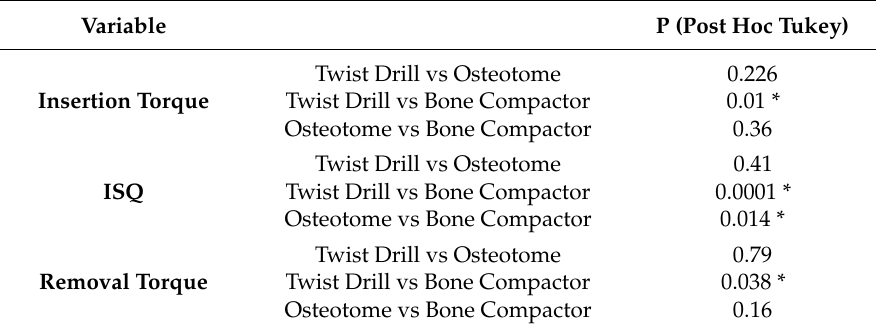
Table 3. Results of Post hoc Tukey test.